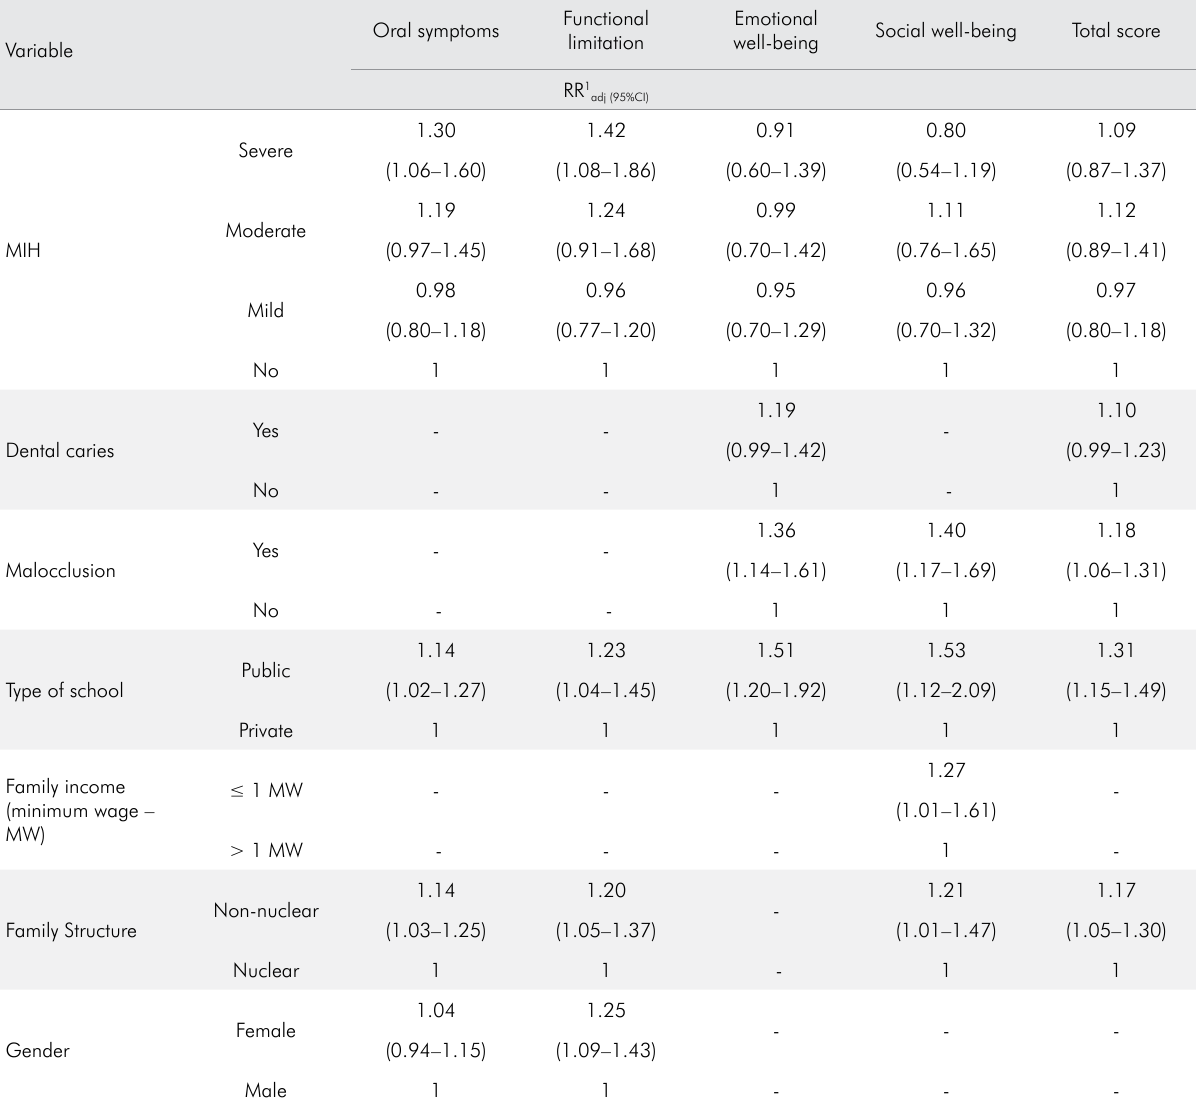
ISF:16 questionnaire with MIH and confounding variables: final multivariate 11-14